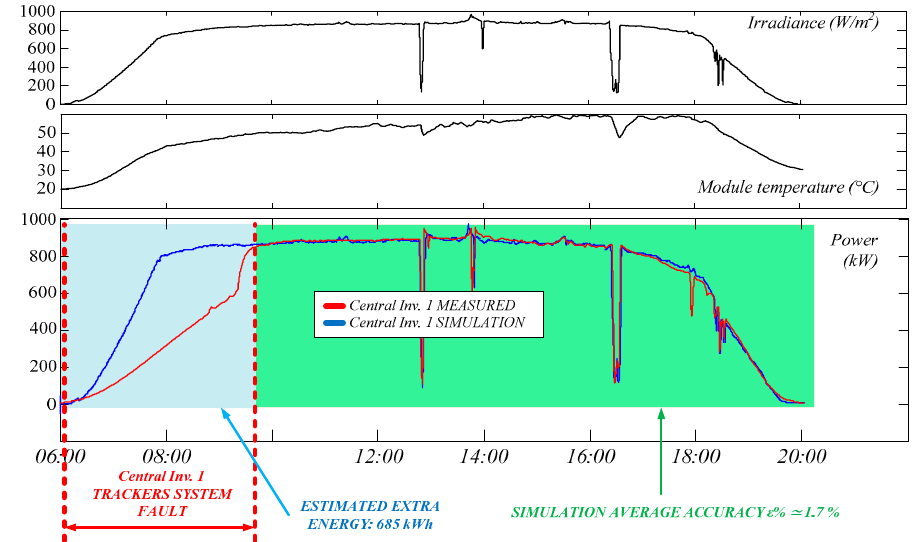
Figure 14. Model output vs. measured data of central inverter 1 subsection during a day in which a fault occurs in trackers power supply. The integrated state-space average model is able to estimate the theoretical extra energy that the subfield could produce in absence of such fault.